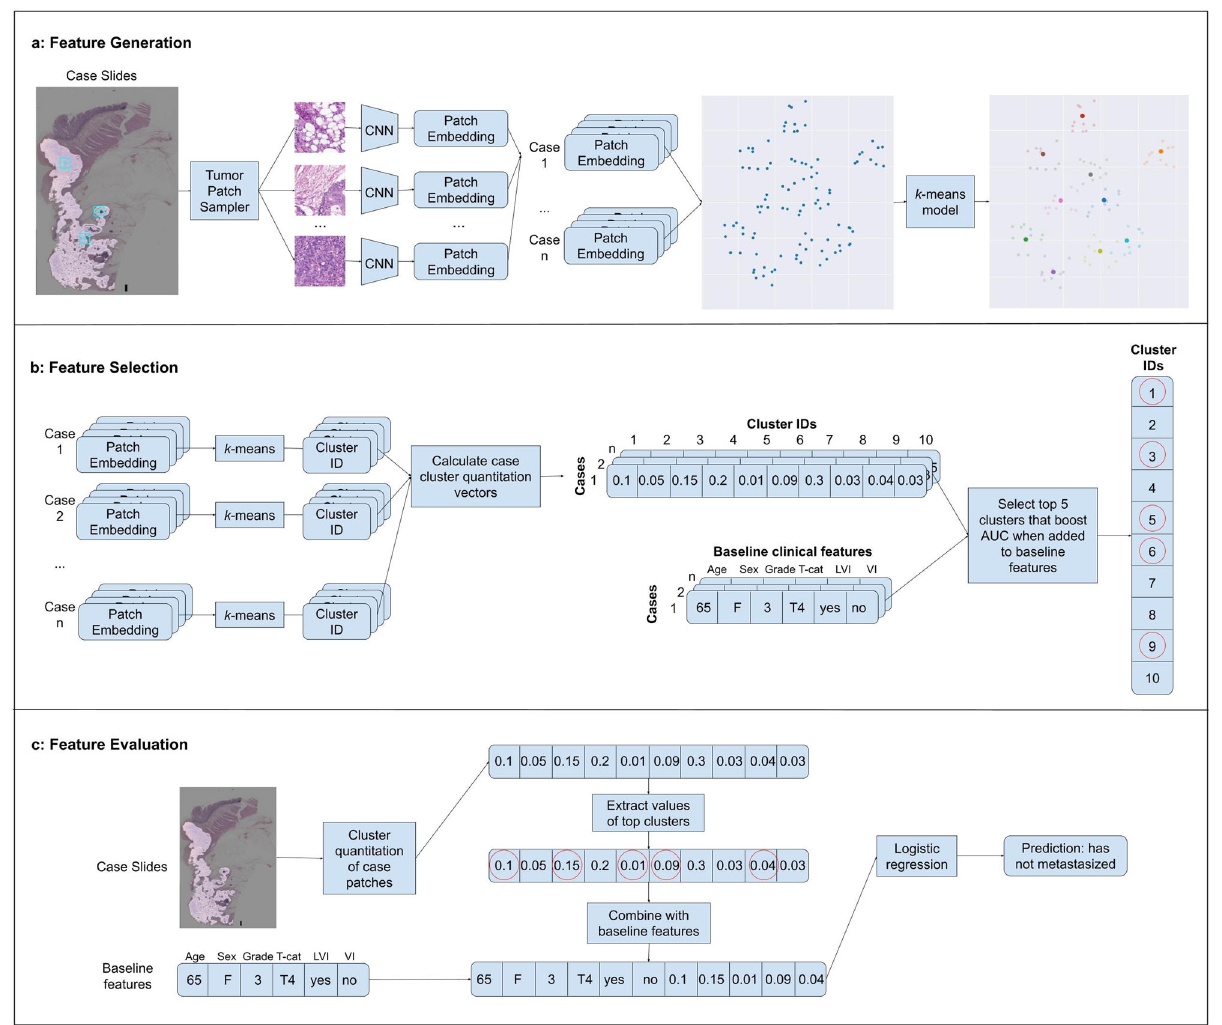
Fig. 1 Overview of model development. a Feature Generation: patches are sampled at random from regions containing tumor of a given case in the training set, and each patch is passed through a CNN to obtain an embedding vector. A k -means algorithm is then fi t on these embeddings. Note: for demonstration purposes in this example only 10 cluster centroids were placed; in our actual model we fi t 200 clusters on the patch embeddings. b Feature Selection: all patch embeddings from a case are run through the trained k -means model and are assigned a cluster id, and the fraction of patches in a case assigned to each cluster is computed (case-level cluster quantitation vector). This is repeated for all cases in the training set. The top 5 clusters are chosen to maximize AUROC in a greedy stepwise forward selection on the training set when combined with baseline clinical features in a logistic regression model. c Feature Evaluation: a cluster quantitation vector is computed for a case to be evaluated, and the cluster quantitations for the pre-selected top cluster ids are concatenated to the baseline clinical features. This case-level combined feature vector is then fed through a logistic regression model to obtain a (Table 3). Receiver operating characteristic curves with AUROCs